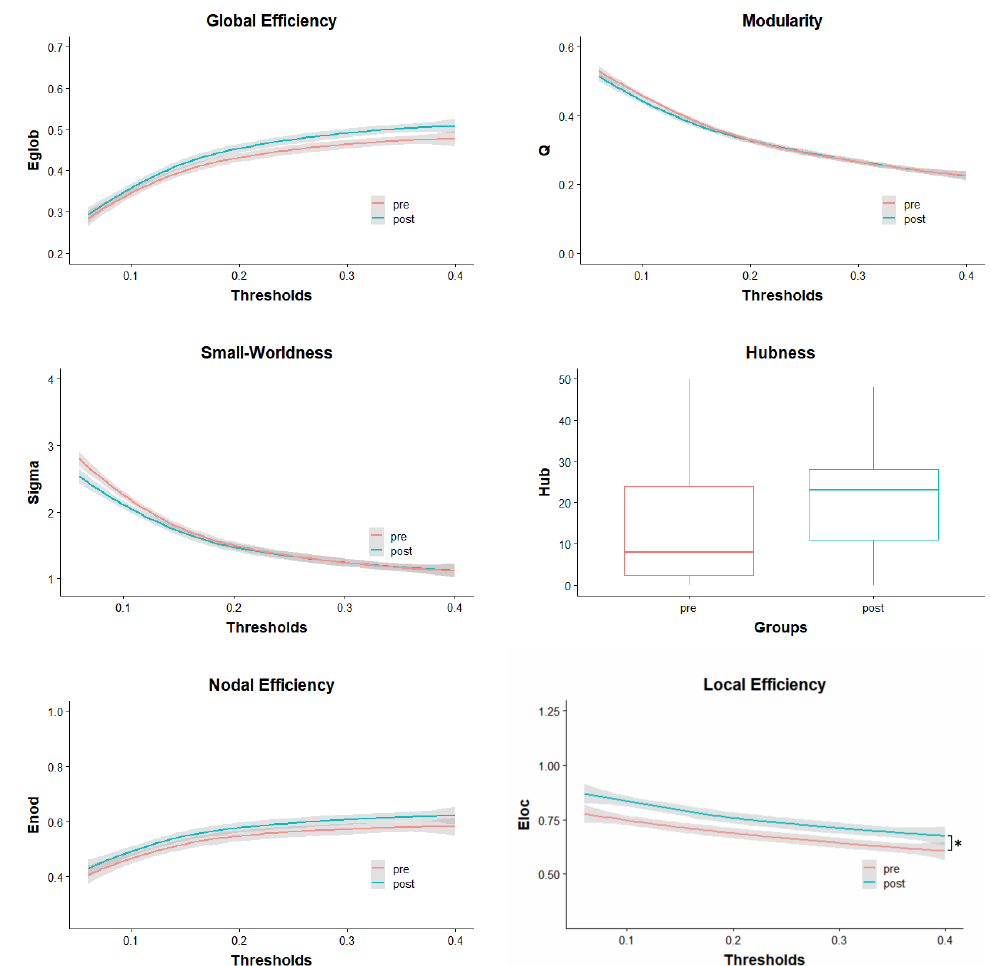
Figure 1. Pre- and post-test distribution of parameters over the full range of used thresholds. The grey areas indicate the standard deviations. In the case of Hubness, the groups are represented in a boxplot. Enod = Nodal Efficiency; Eloc = Local Efficiency; Eglob = Global Efficiency; Q = Modularity; Sigma = Small-Worldness; Hub = number of Hubs; * = significant